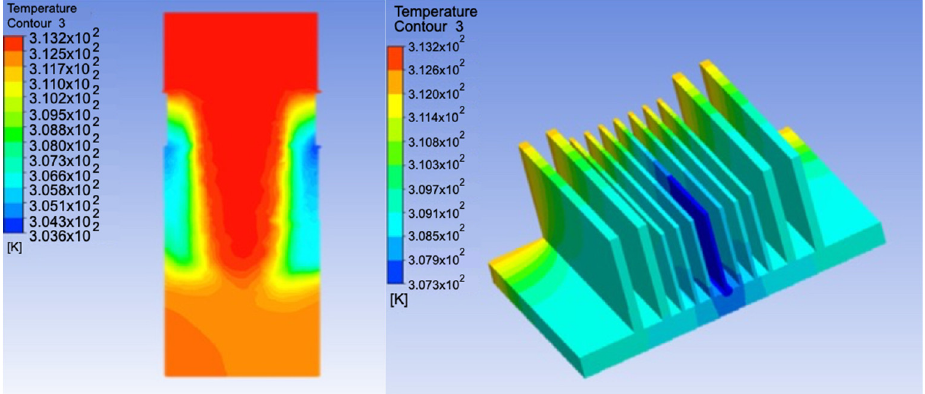
Figure 10. Temperature distribution on the device and cooling surface.